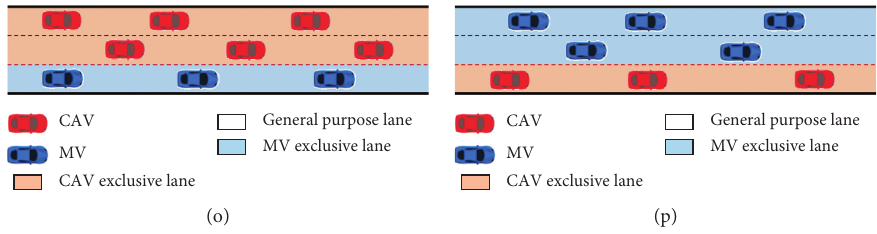
Figure 1: Twelve scenarios with different lane policies. (a) GG. (b) GC. (c) GM. (d) CM. (e) GGG. (f) CGG. (g) GCG. (h) MGG. (i) GMG. (j) CCG. (k) CGC. (l) MMG. (m) MGM. (n) CGM. (o) CCM. (p)